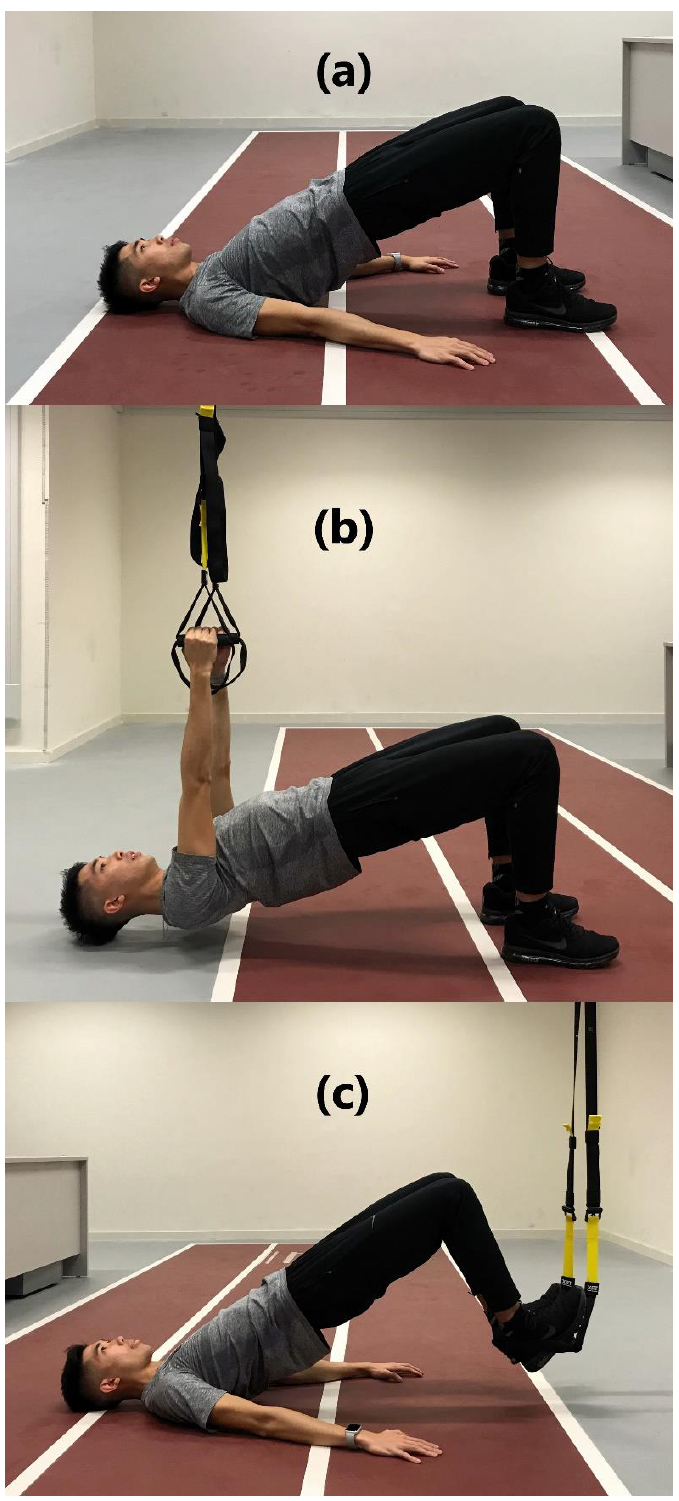
Figure 2. ( a ) Regular supine bridge (Supine con ) is a supine bridge position with feet shoulder-width apart. The arms were placed beside the torso, and the knees were flexed at 90° with both feet resting on the exercise mat. The pelvis was lifted and aligned with the thigh; ( b ) supine bridge with arm suspension (Supine-Arm suspension ) is similar to the regular supine bridge position, but the suspension handle was held in a neutral grip position and straight-arm position being perpendicular to ground level; ( c ) supine bridge with feet on a suspension system (Supine-Feet suspension ) is similar to the regular supine bridge position, but the feet were placed onto the suspension strap in shoulder width.